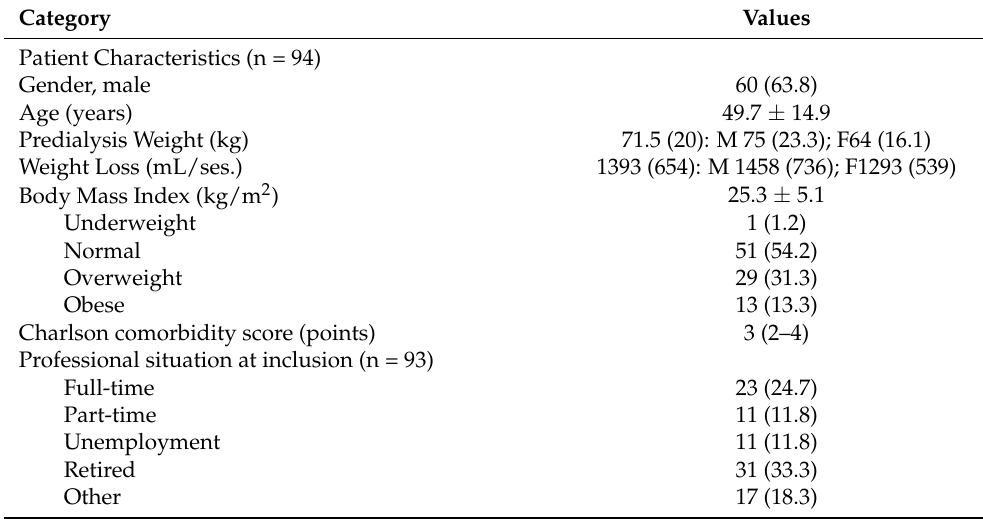
Table 1. Patient